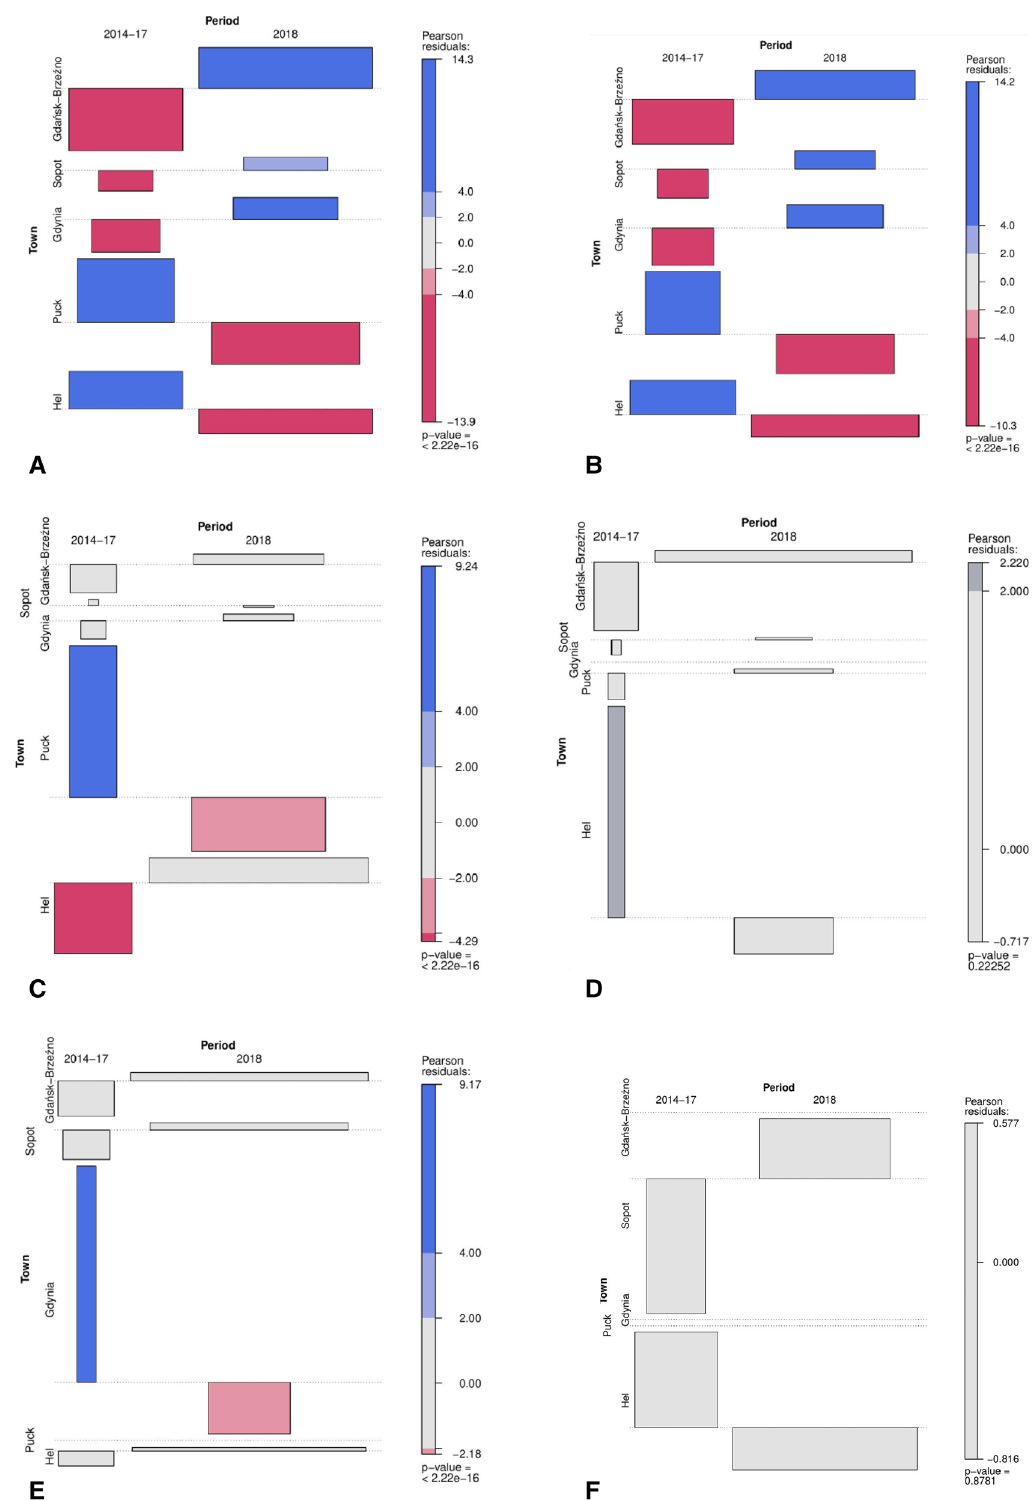
Figure 2. The association of the contingency table with the mean quantity of psychrophilic ( A ) and mesophilic bacteria ( B ), coliform ( C ) and E. coli ( D ) bacteria, P. aeruginosa ( E ) and S. aureus ( F ) bacteria detected in the air samples collected from the Bayof Gdańsk in Hel, Puck, Gdynia, Sopot and Gdańsk-Brzeźno and the time period for the sample collection (2014–2017 and 2018). The blue colour indicates that the observed value is higher than the expected value if the data was random. The red colour specifies that the observed value is lower than expected and the grey colour indicates that the observed value is close to the